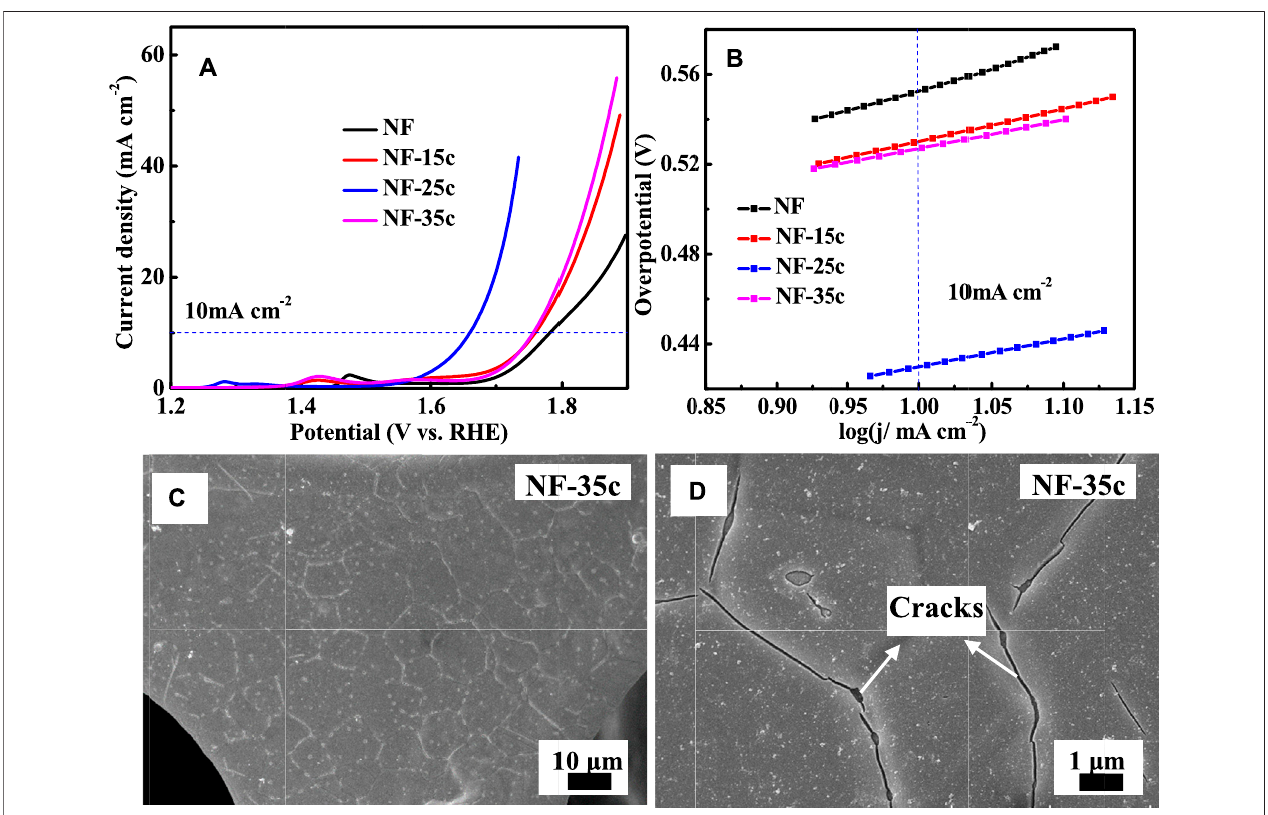
FIGURE 3 | OER measurement curves of the electrode with different cycles of electrodeposition (A) LSV curves and (B) Tafel slopes. The (C) low and (D) high magni fi cation SEM images of NF-MnO 2 electrode with pulse electrodeposition for 35 cycles.